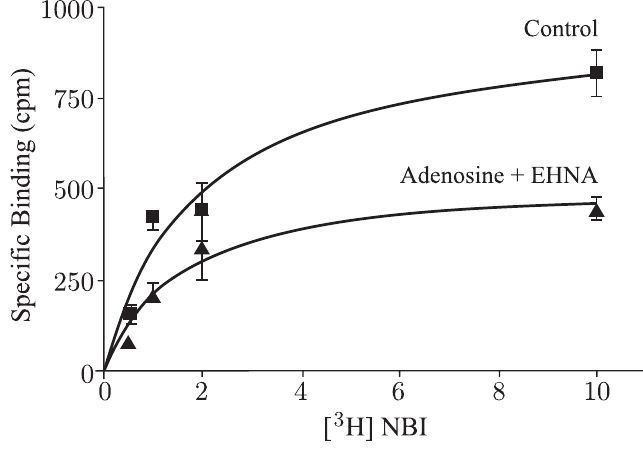
Fig. 4 – Effect of adenosine treatment on the binding of ( 3 H)NBI to cultured reti- nal cells. Control cultures or cultures treated for 5 days with adenosine ( 100 µ M ) plus EHNA ( 10 µ M ) , an adenosine deaminase inhibitor, were incubated in saline containing increasing concentrations of ( 3 H)NBI in the absence or presence of unlabeled NBI ( 10 µ M ) for determination of specific binding. A significant reduction of B max values were observed in treated cultures ( 975 . 6 ± 106 . 3 to 533 . 1 ± 74 . 9 cpm) but not of K d (1 . 9 ± 0 . 6 to 1 . 5 ± 0 . 6), indicating a decrease in the number but not the affinity of